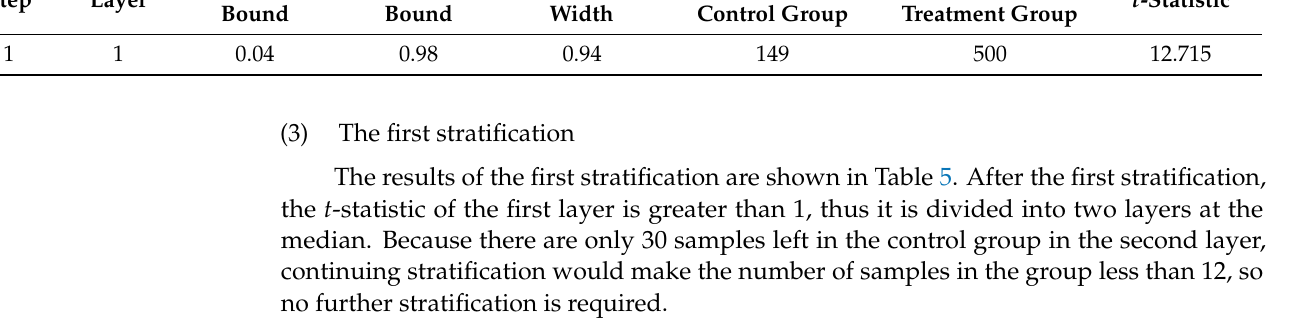
Table 5. The results of the first